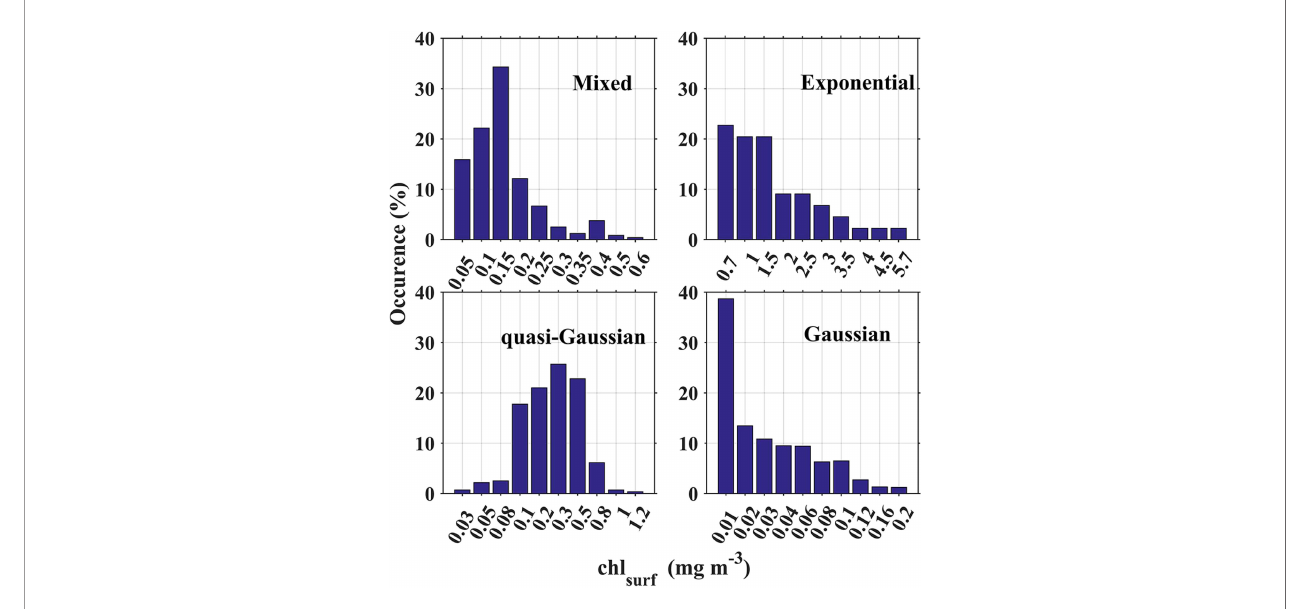
FIGURE 4 | Surface concentrations of Chl-a on the different types of vertical pro fi